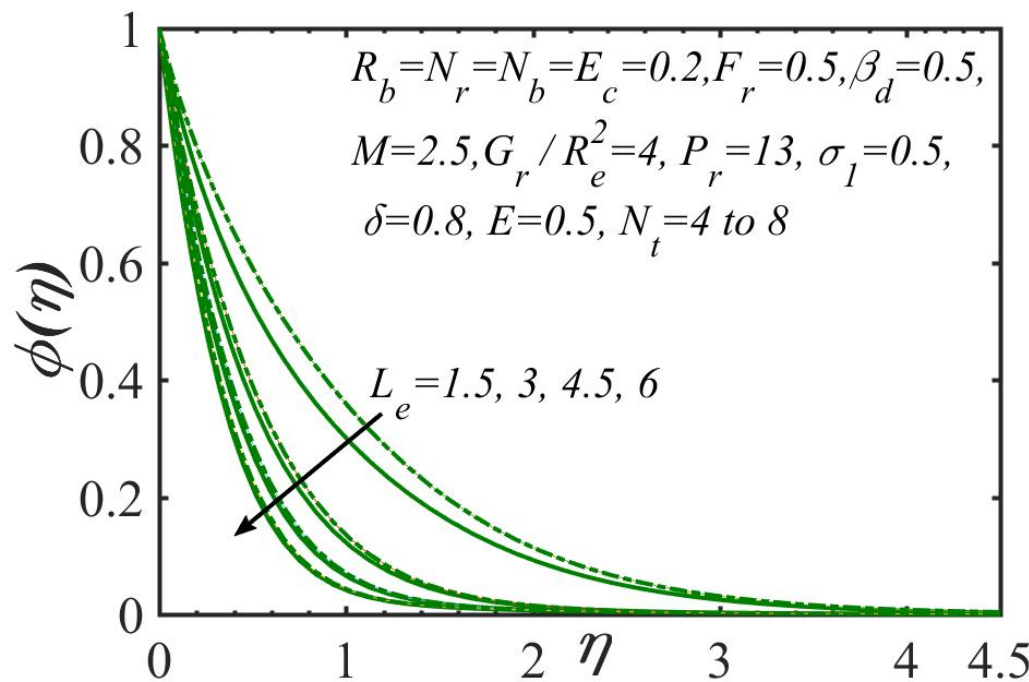
Figure 10. Influence of the bio-convection Lewis number L e and the thermophoresis parameter “ N t ” on concentration distribution. Solid line: N t = 4, Dotted line: N t = 8.